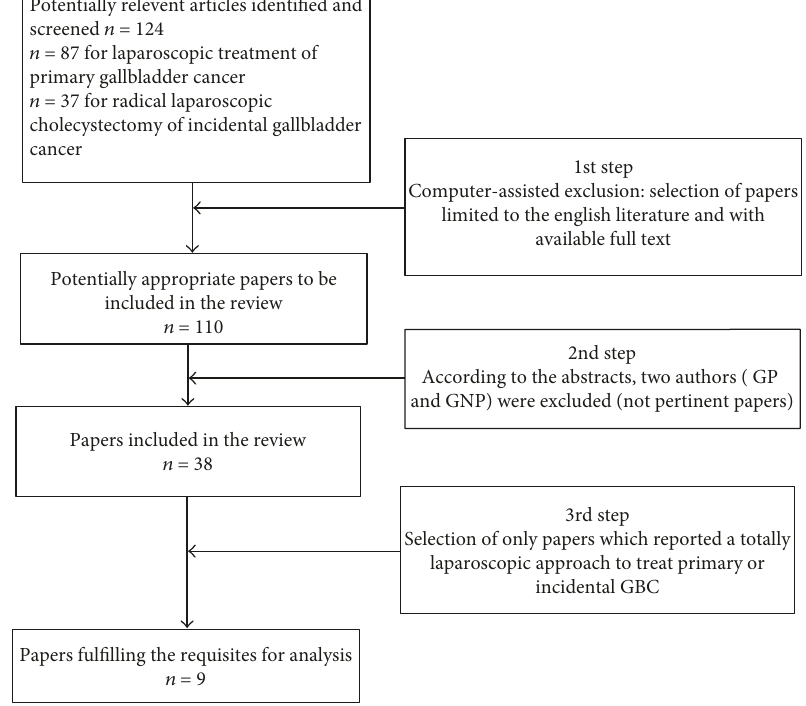
Figure 1: Diagram showing the study methodology and the number of abstracts and articles identi fi ed and evaluated during the review